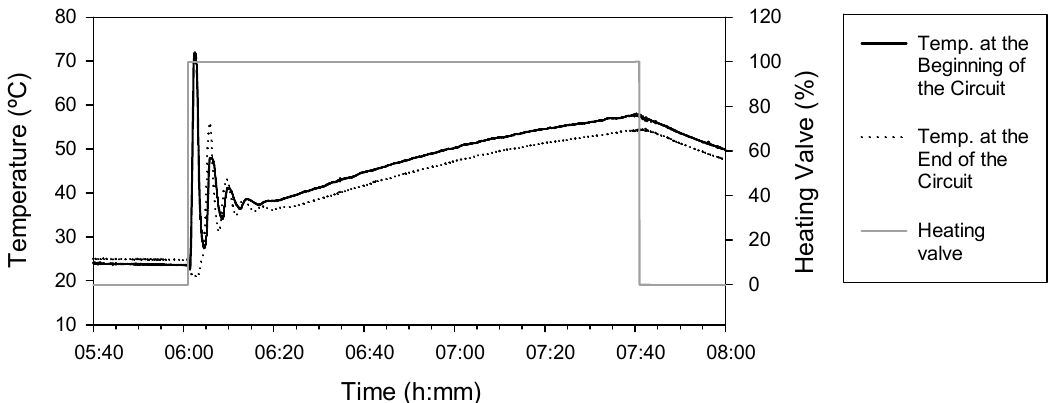
Figure A4. Water temperature at the beginning and end of the greenhouse circuit over a period when some biomass combustion was performed. The heating valve has also been plotted to identify the precise time when the heating was performed.